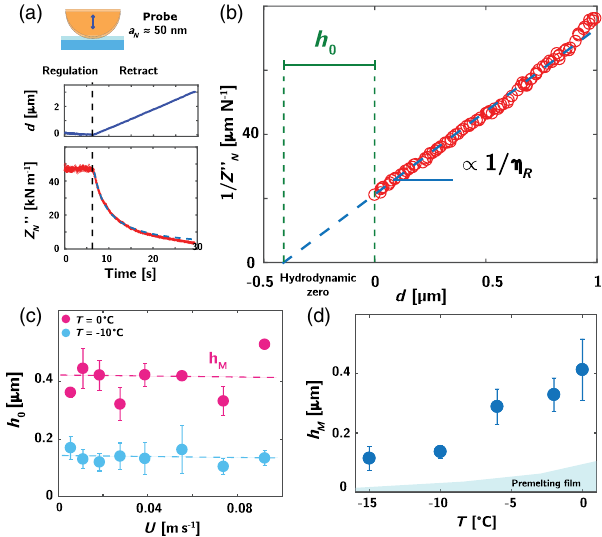
FIG. 2. Measuring the thickness of the interfacial film. (a) Re- tract curve for the dissipative ( Z 00 N , red) normal mechanical impedance while the bead is simultaneously shearing the ice surface at speed U ¼ 0 . 01 m s − 1 ( T ¼ − 2 °C). Under regulation, a steady state is reached. Upon withdrawal, the impedance Z (cid:2) relaxes smoothly to zero. (b) Inverse of the mechanical imped- ance 1 =Z 00 N as a function of the retract distance d (during the retract phase). The linear variation of 1 =Z 00 N versus the distance is accounted for by the Reynolds formula, Eq. (1), and points to the liquidlike nature of the interfacial layer. (c) Measured thickness h T ¼ − 10 °C and 0 as a function of speed for two temperatures ( T ¼ 0 °C). In each case, there is no variation with the shearing speed U . Measurements are performed under the same load L ¼ 4 . 5 mN. (d) Average thickness h T . As M as a function of intuitively expected, we observe an increase in the film thickness as we approach the melting point. An upper limit for the thickness of the premelting film on ice taken from literature is shown in pale blue